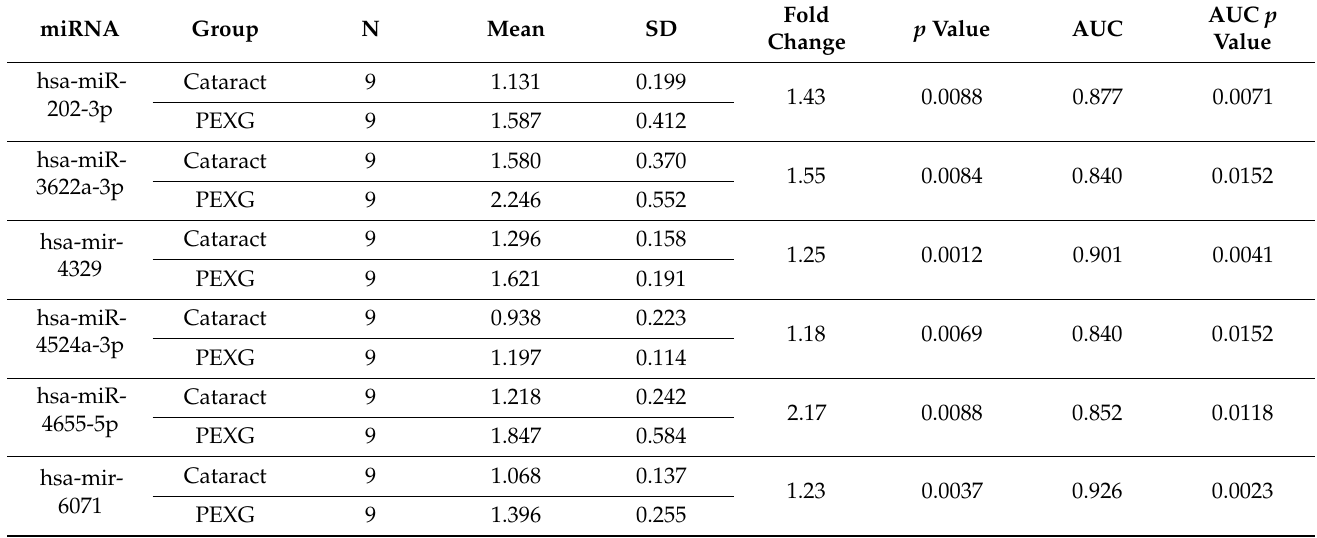
Table 3. 10 miRNA upregulated in the PEXG group compared to the cataract group